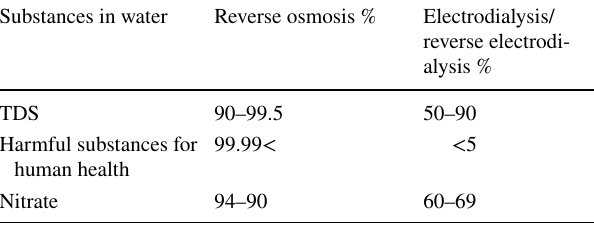
Table 4 Comparison of particle separation from water by reverse osmosis and electrodialysis/reverse electrodialysis methods (Cotruvo et al.